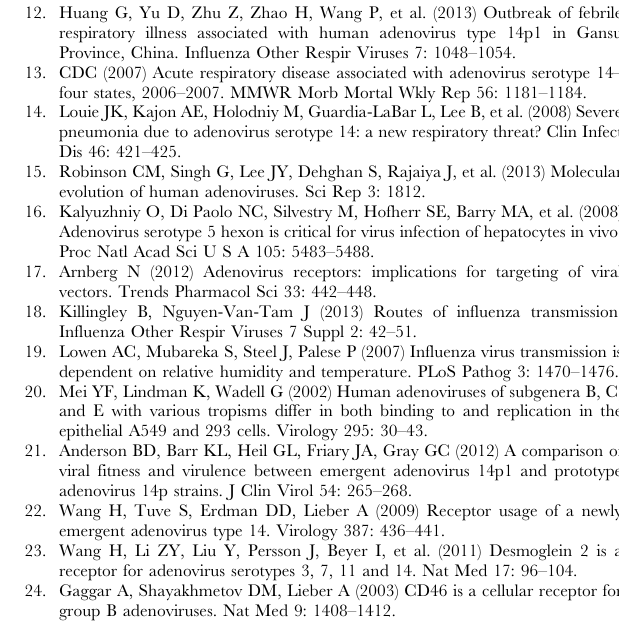
Figure S1 The standard curves of qPCR for HAdV-B11 (A), HAdV-B14 (B) and HAdV-B55 (C), respectively. Real- time PCR assays were performed using viral DNAs for each assay. The 10-fold serial dilutions of viruses were used as standard samples for standard curve analysis. The slope, the Y-intercept and the R2 value were